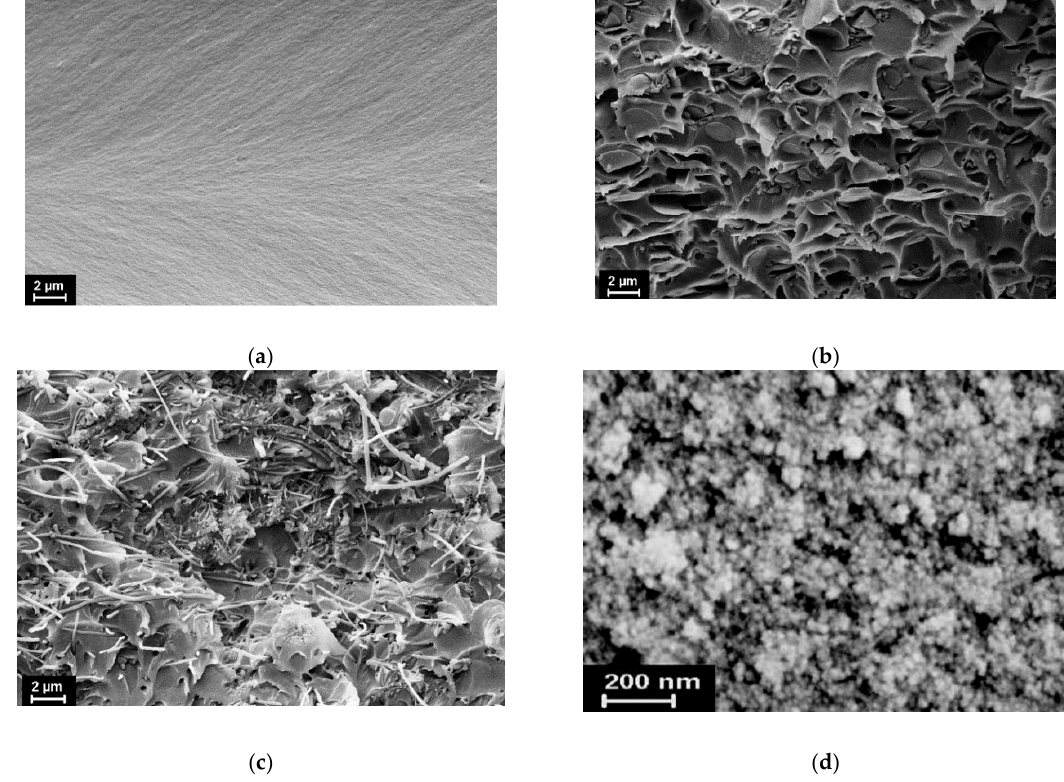
Figure 3. Scanning electron microscopy (SEM) images of ( a ) pristine DPhO-BAPS